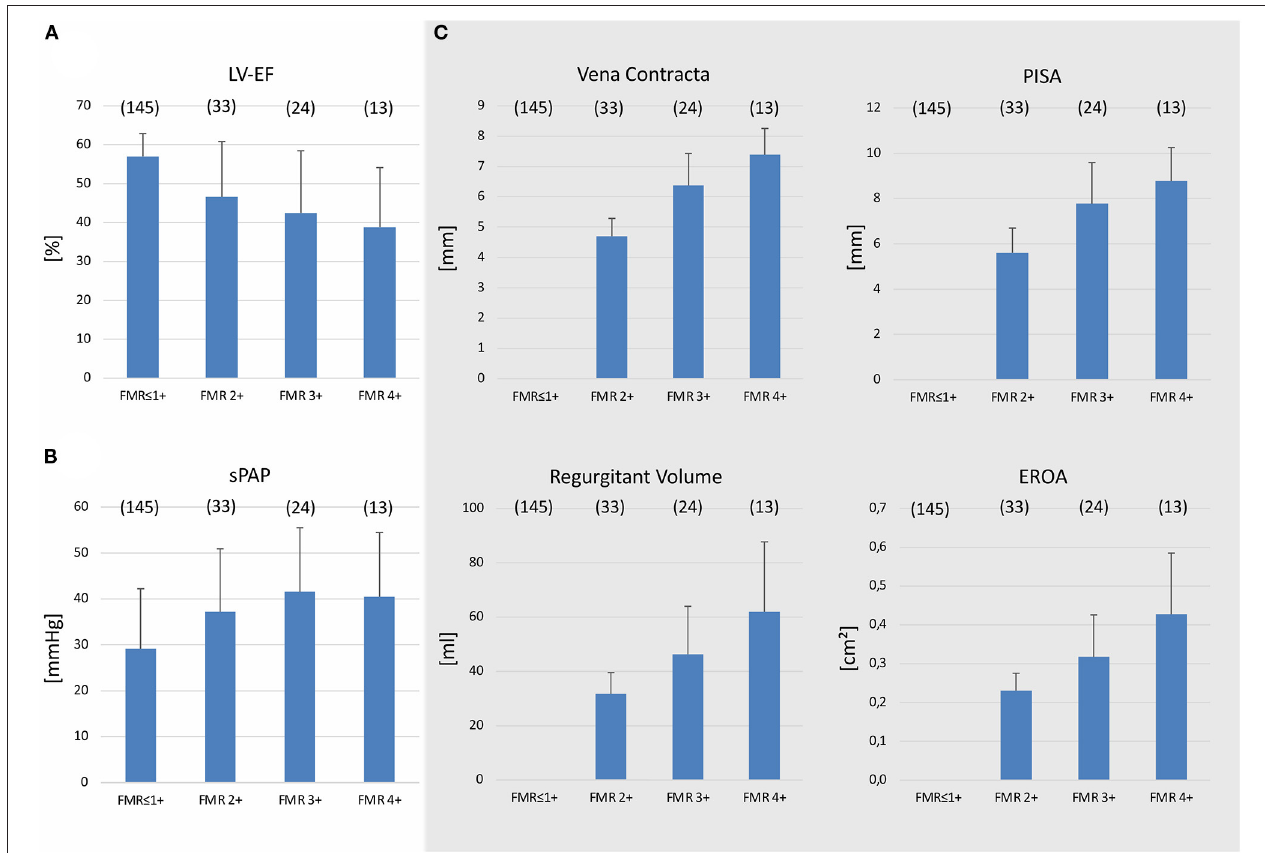
FIGURE 2 | Echocardiographic evaluation of patients with and without functional mitral valve regurgitation. Left ventricular ejection fraction (LVEF) (A) and systolic pulmonary artery pressure (sPAP) (B) in patients with functional mitral regurgitation (FMR) ≥ 2 + or FMR ≤ 1 + . Patients with FMR ≥ 2 + were separated according to a standard classification (FMR 2 + , 3 + , and 4 + ). (C) Quantitative echocardiographic assessment including measurement of vena contracta, proximal isovelocity surface area (PISA), effective regurgitant orifice area (EROA), and regurgitant volume in patients with FMR ≥ 2 + . Mean ± SD .